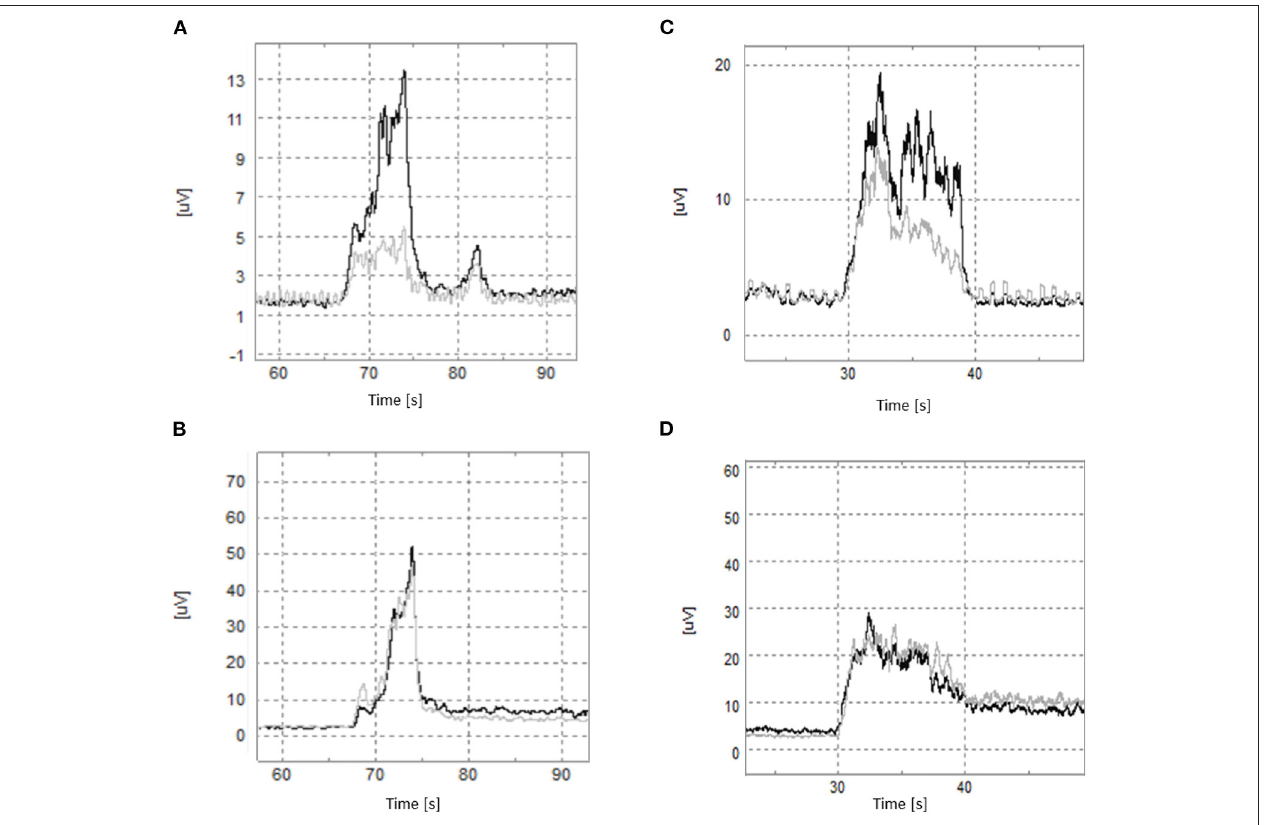
FIGURE 2 | The typical RMS in elbow flexion. Patients with stroke: (A) the black line is the clavicle part of the pectoralis major (PC), and the gray line is the pectoralis costal part of the pectoralis major (PS). (B) The black line is the Flexor Carpi Radialis (FCR), and the gray line is Flexor Carpi Ulnaris (FCU). Healthy controls: (C) the black line is PC, and the gray line is PS. (D) The black line is FCR, and the gray line is FCU.